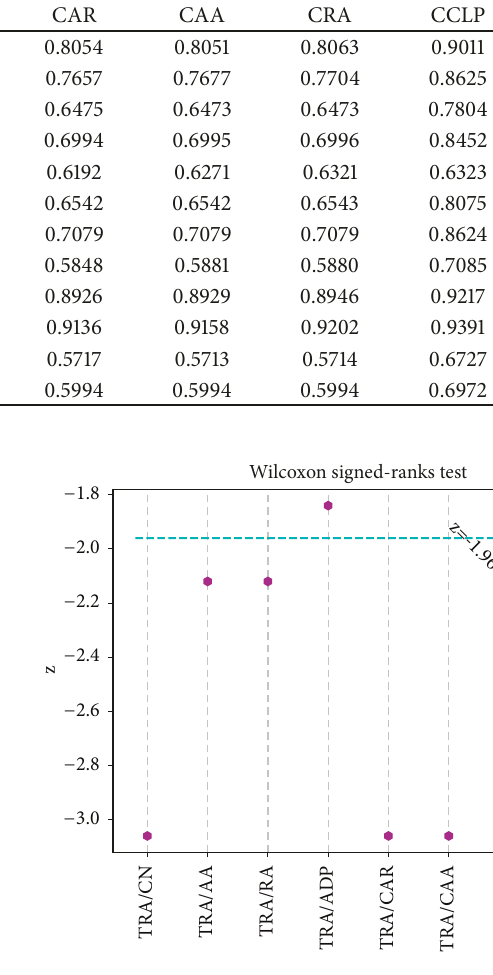
Figure 2: The results of Wilcoxon signed-ranks test based on Table 3. With 𝛼 = 0.05 , if 𝑧 <= −1.96 , thenull-hypothesis is